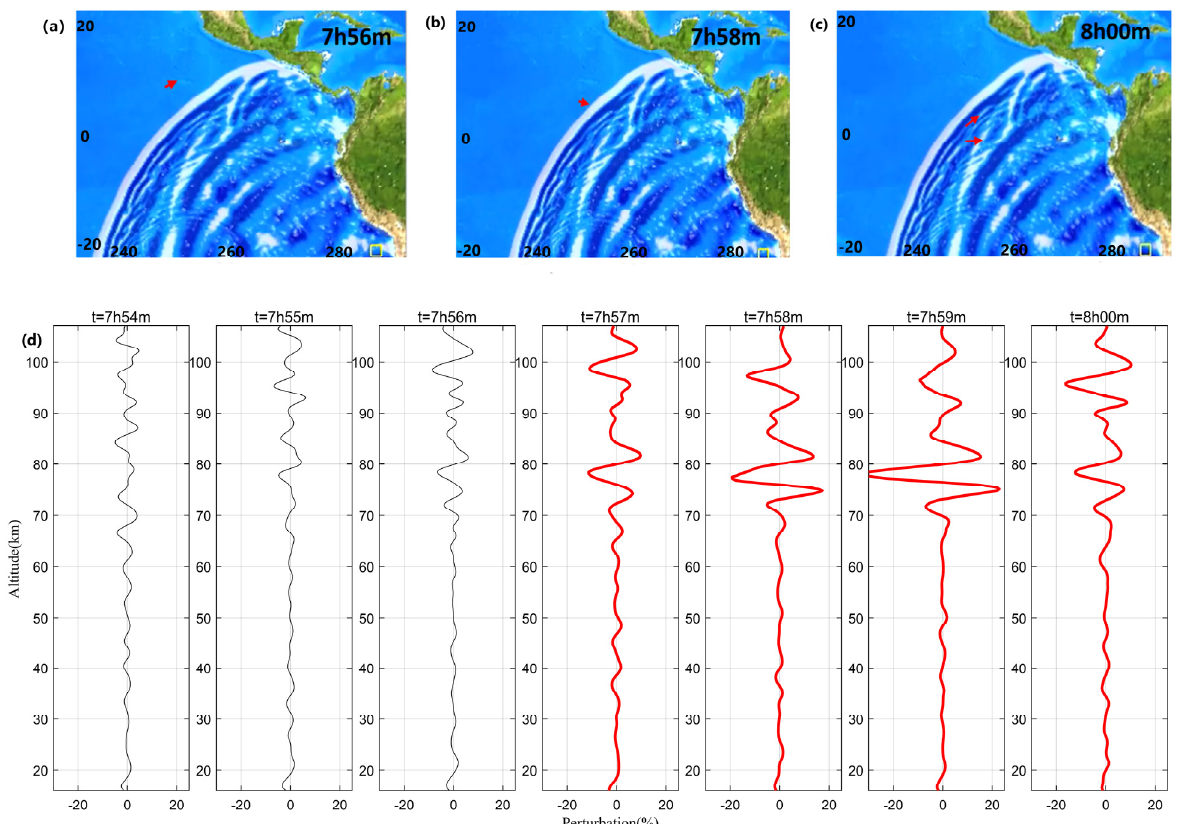
Figure 12. ( a – c ) The tsunami waves (http://nctr.pmel.noaa.gov/chile20150916/ (accessed on 1 July 2022)) at three adjacent moments (7h56m, 7h58m, and 8h00m), the red arrows represent the four observations (7h57m, 7h58m, 7h59m, and 8h00m) of SABER closest to the above three moments. ( d ) Panels from left to right record the temperature perturbations at seven different moments, respec- tively.